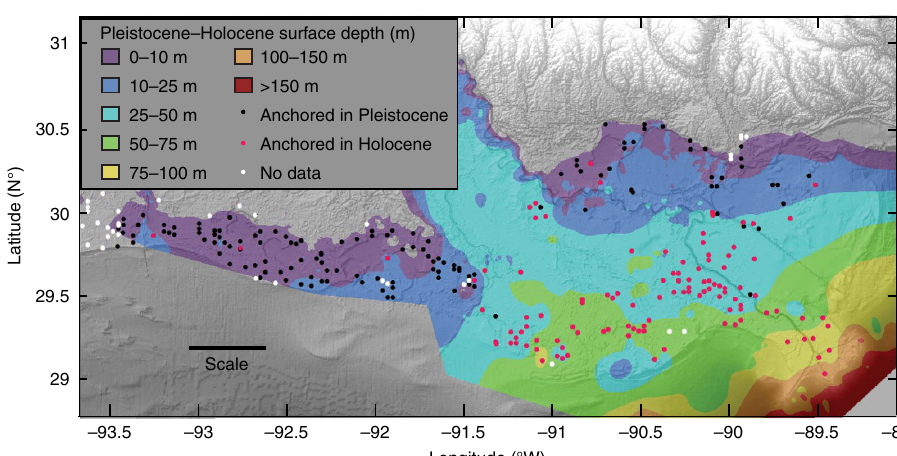
Figure 3 | Surface-elevation table rod depth compared to the depth of the Pleistocene-Holocene contact in coastal Louisiana. Depths are with respect to North American Vertical Datum of 1988. Because the surface elevation at the 274 sites used in this study ranges from (cid:2) 0.2 to 0.6m, the map 43 can be interpreted as a Holocene isopach map. Scale bar,